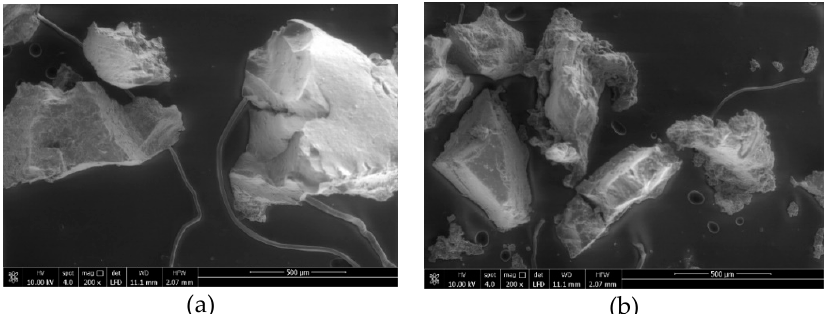
Figure 3. Environmental Scanning Electron Microscope (ESEM) micrographs of the ( a ) first type of crumb rubber (CR) (CR-A) and ( b ) second type of CR (CR-B) particles at 200 ×